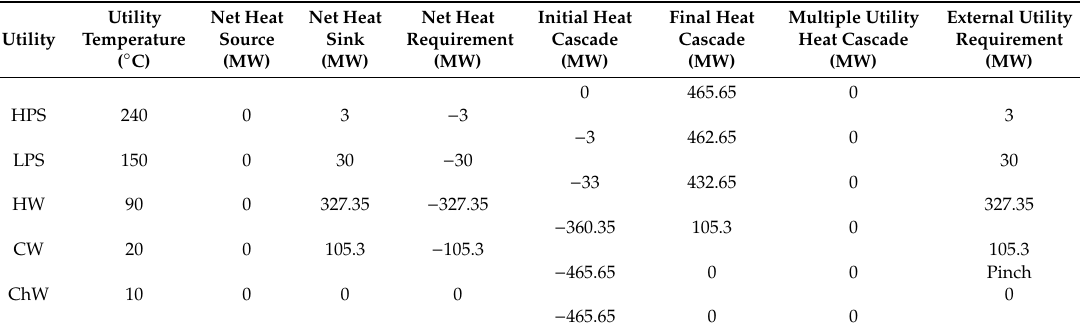
Table 10. TS PTA for all industrial plants from 20 to 6